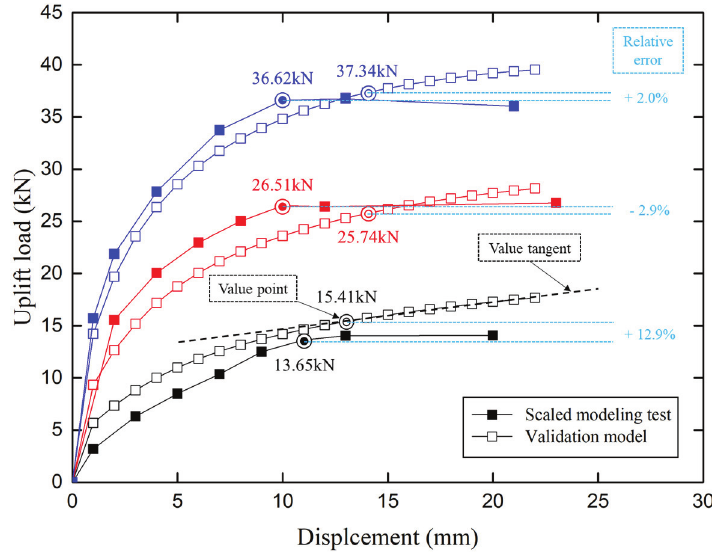
Figure 14. Verification results between the numerical modeling and the reduced-modeling tests.